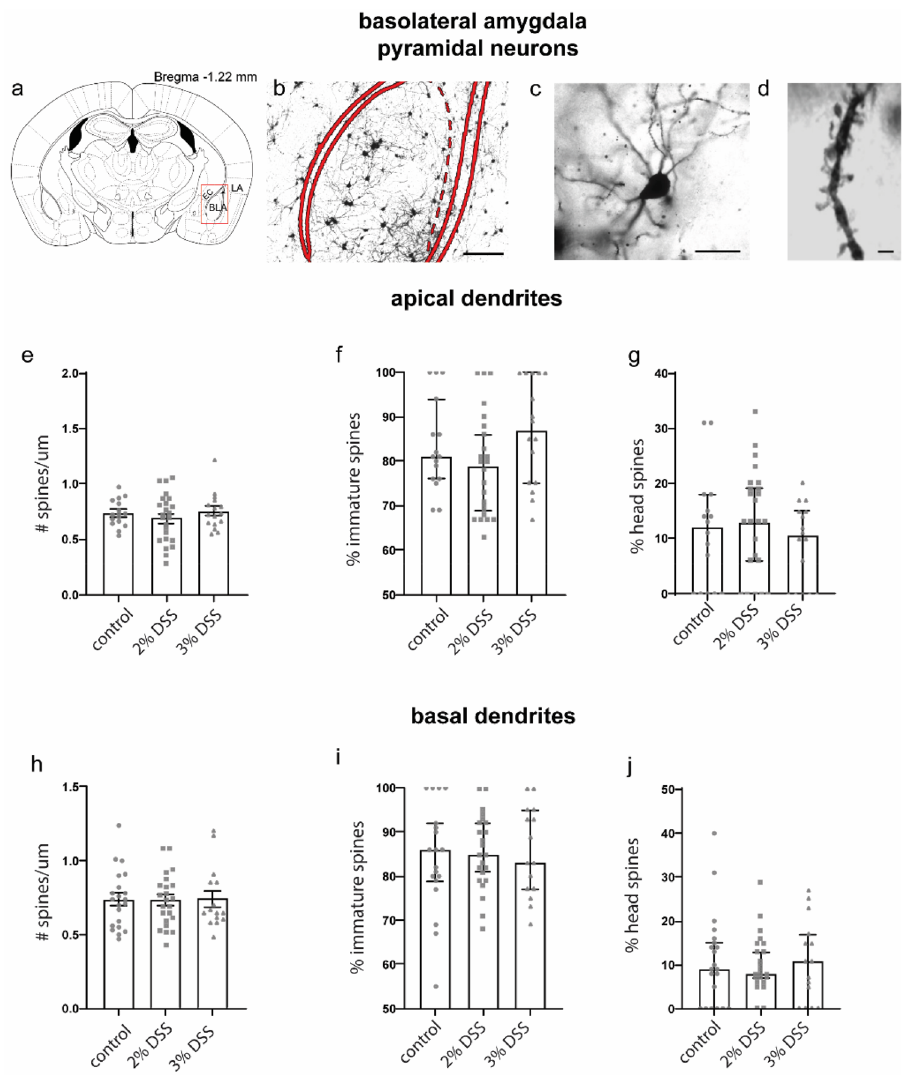
Figure 3. Spine density and composition on basal and apical dendrites of pyramidal cells in the basolateral amygdala. ( a ) Region of interest illustrated on a standard mouse brain atlas, ( b ) Photomicrograph of Golgi labeled cells in basolateral amygdala (BLA) region in a mouse brain (scale bar: 200 µm). ( c ) Representative image of a BLA pyramidal neuron (scale bar: 25 µm) ( d ) Representative image of dendrite selected for spine counting (scale bar: 2 µm). ( e ) Density of spines on basal dendrites in BLA; data shown are mean ± SEM. Proportion of immature spines ( f ) and head spines ( g ) on basal dendrites in the BLA; data shown are median ± 95% CI. ( h ) Density of spines on apical dendrites in BLA, data shown are mean ± SEM. Proportion of immature spines ( i ) and head spines ( j ) on apical dendrites in the BLA; data shown are median ± 95% CI. Density data analyzed by One-way ANOVA with Dunnett’s post-test to negative control, data shown as mean ± SEM, *p < 0.05. Composition data analyzed by Kruskal–Wallis. n = 15–24 dendrites, from 12 to 19 neurons, from 5–6 animals per